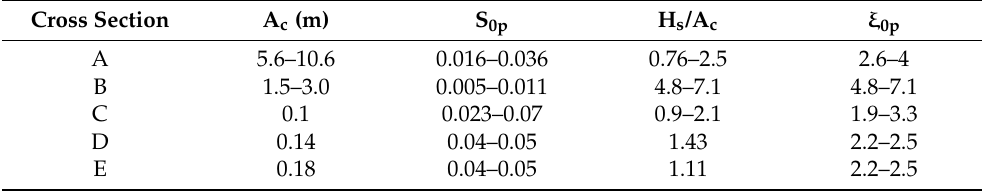
Table 2. Limits of validity for the application of the formulation of Jensen, 1984, and Bradbury et al., 1988. Cross